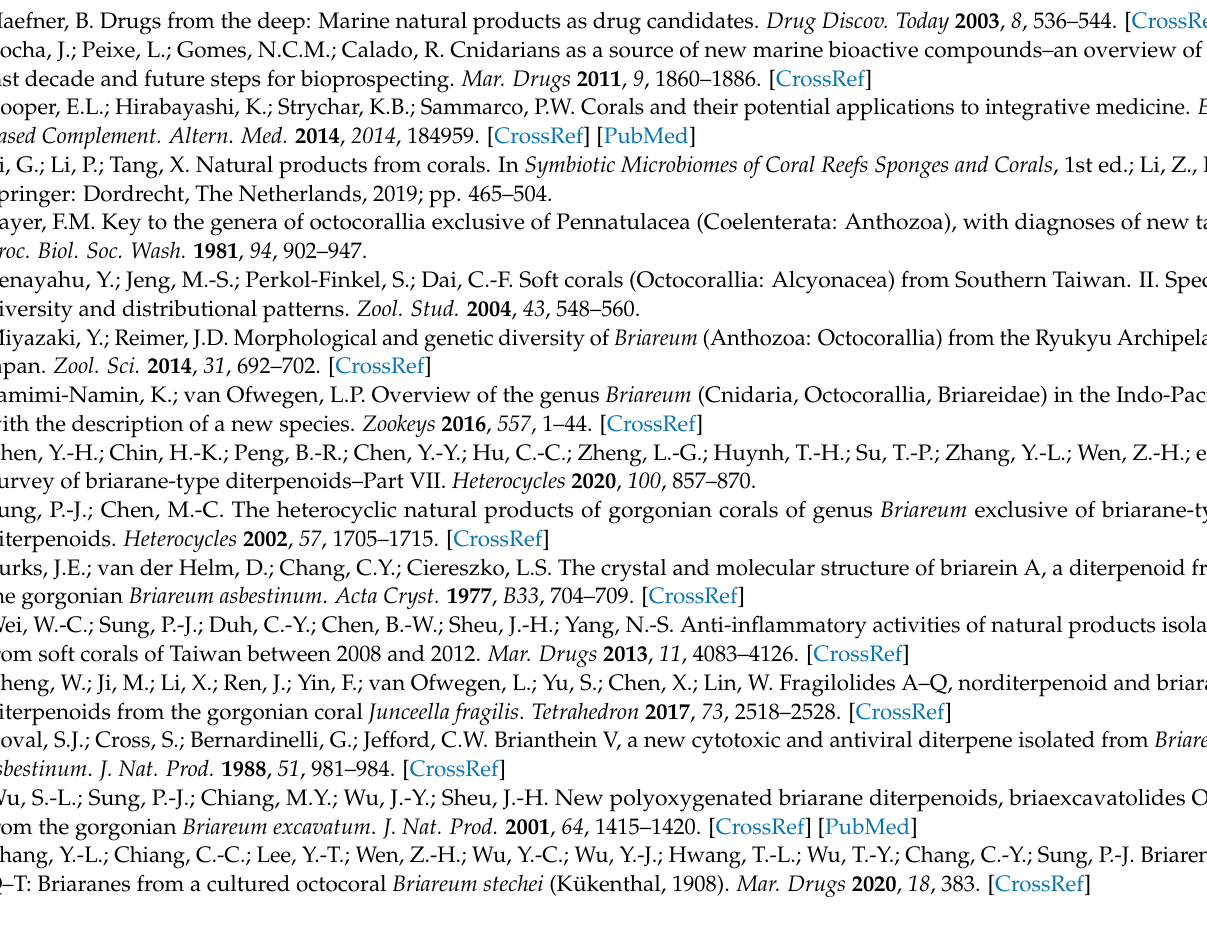
Figure S9: NOESY spectrum of 2 , Figure S10: ESIMS spectrum of 3, Figure S11: HRESIMS spectrum of 3 , Figure S12: IR spectrum of 3 , Figure S13: 1 H NMR spectrum of 3 in CDCl 3 at 400 MHz, Figure S14: 13 C NMR spectrum of 3 in CDCl 3 at 100 MHz, Figure S15: HSQC spectrum of 3 , Figure S16: HMBC spectrum of 3 , Figure S17: 1 H- 1 H COSY spectrum of 3 , Figure S18: NOESY spectrum of 3